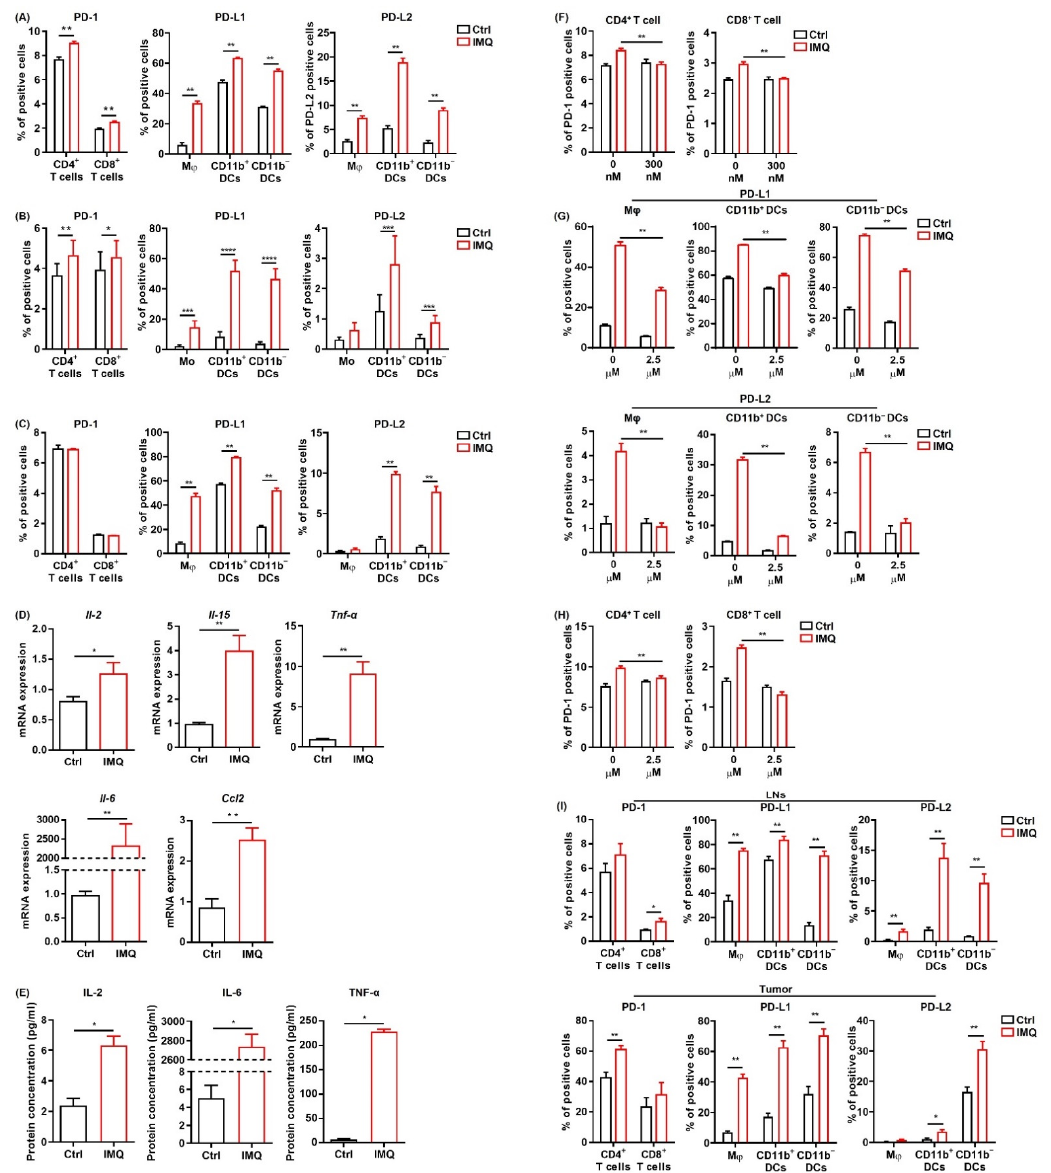
Figure 5. IMQ upregulates the expression of PD-1/PD-L1/PD-L2 in immune cells. ( A – C ) Flow cytometric analysis of PD-1 expression in CD4 + T cells and CD8 + T cells, and PD-L1 and PD-L2 expression in myeloid cells of the murine spleen ( A , C ) and human blood ( B ) stimulated with IMQ for 24 h ( A , B ) or 6 h ( C ) ( n = 6 ( A , C ) and n = 18 ( B ) in each group, respectively). ( D ) Quantitative RT-PCR analysis of cytokine expression of murine splenocytes stimulated with IMQ for 6 h ( n = 6 in each group). ( E ) Cytokine concentrations in culture supernatants of splenocytes 24 h after IMQ stimulation ( n = 4 in each group). ( F ) Flow cytometric analysis of PD-1 in CD4 + T cells and CD8 + T cells stimulated with IMQ in the absence or presence of 300 µ M of tofaicitinib for 24 h ( n = 6 in each group). ( G , H ) Flow cytometric analysis of PD-L1 and PD-L2 expression in myeloid cells ( G ) and of PD-1 expression in CD4 + T cells and CD8 + T cells ( H ) stimulated with IMQ in the presence of 2.5 µ M of BMS-345541 for 24 h ( n = 6 in each group). ( I ) Flow cytometric analysis of PD-1 expression in CD4 + T cells and CD8 + T cells and of PD-L1 and PD-L2 expression in myeloid cells in the lymph nodes and tumor 5 days after tumor inoculation with IMQ application at day 4 (n = 6 in each group). Ctrl: control, IMQ: imiquimod, M ϕ : macrophages, Mo: monocytes, DCs: dendritic cells, LNs: lymph nodes. Error bars indicate ± 1 SEM; * p < 0.05, ** p < 0.01, *** p < 0.001, **** p <